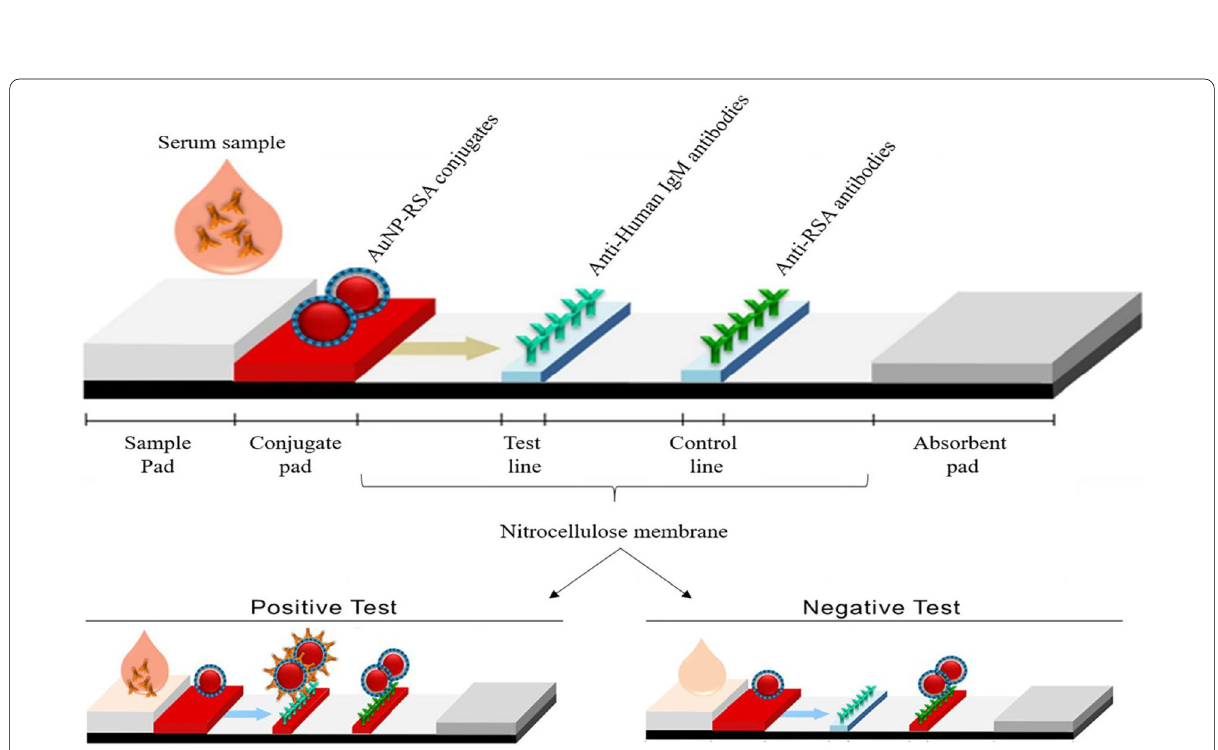
Fig. 4 AuNP-based LFAs for detection of IgM P. jirovecii antibodies. The presence (positive test) or absence (negative control) of the P. jirovecii antibodies could be differentiated by the AuNP reddish color in both test and control lines, or only in the control line, respectively. Reproduced with permission [70]. Copyright 2019, Frontiers in